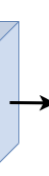
Figure 2. Pixel Shuffle layer.